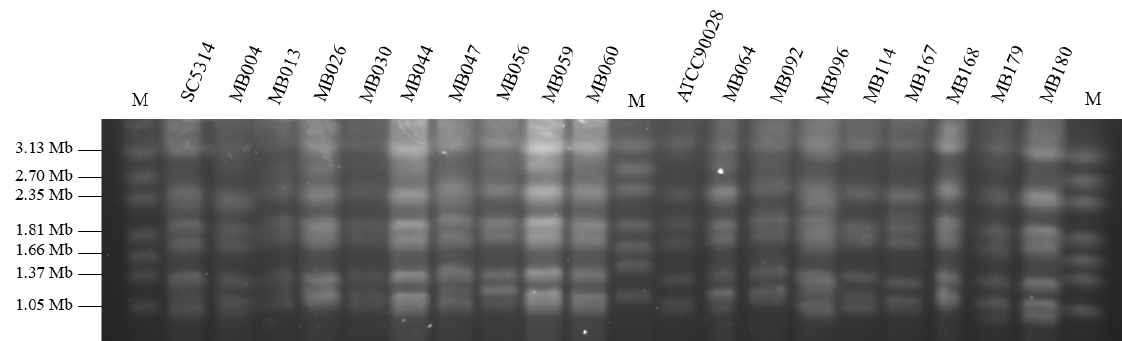
Figure 2. PFGE karyotypes of 17 Candida albicans clinical isolates (MB004-MB180) recovered from blood and sputum of COVID-19 patients. M: DNA Size Standard, Hansenula wingei ; SC5314 & ATCC90028— Candida albicans reference strains